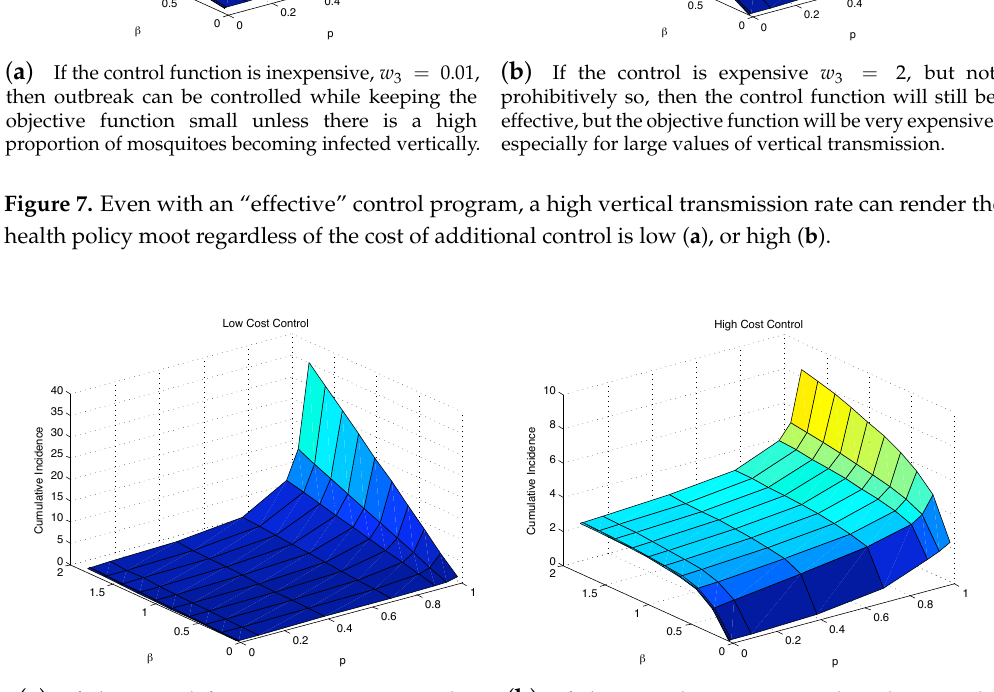
( a ) If the control function is inexpensive, then ( b ) If the control is expensive, then the control incidence can be controlled unless there is a high function can only reduce incidence by a limited factor. proportion of mosquitoes becoming infected vertically and the transmission rate is high. Figure 8. The outbreak can be well controlled except when vertical transmission is extremely high. Although this situation is unrealistic, it highlights the importance of a control strategy, whether highly cost-efficient, left, or otherwise to take into consideration all possible transmission